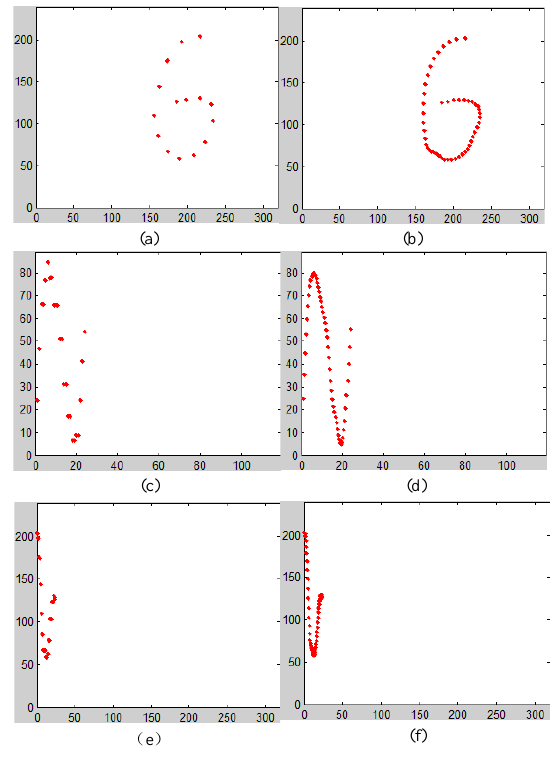
Figure 8. Normalization of digit track “6”